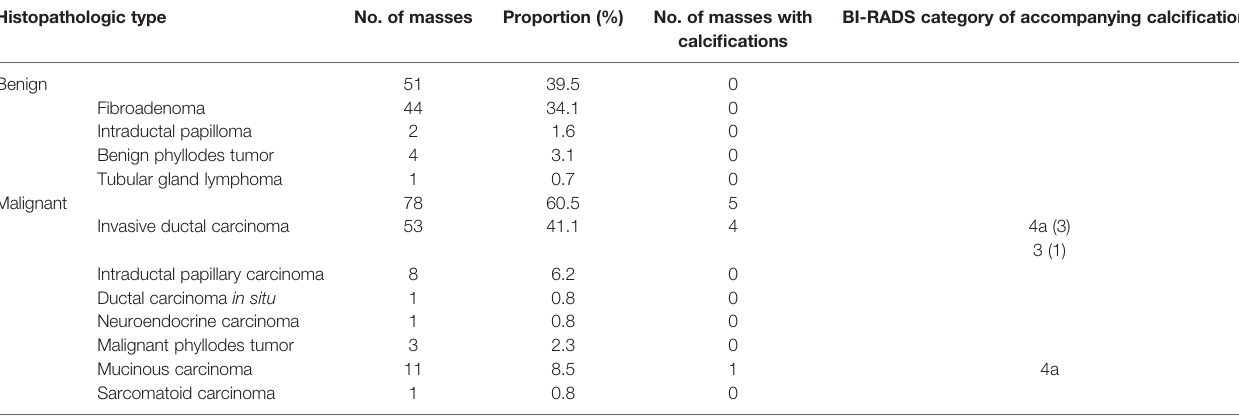
TABLE 1 | Features of 129 breast tumors con fi rmed by